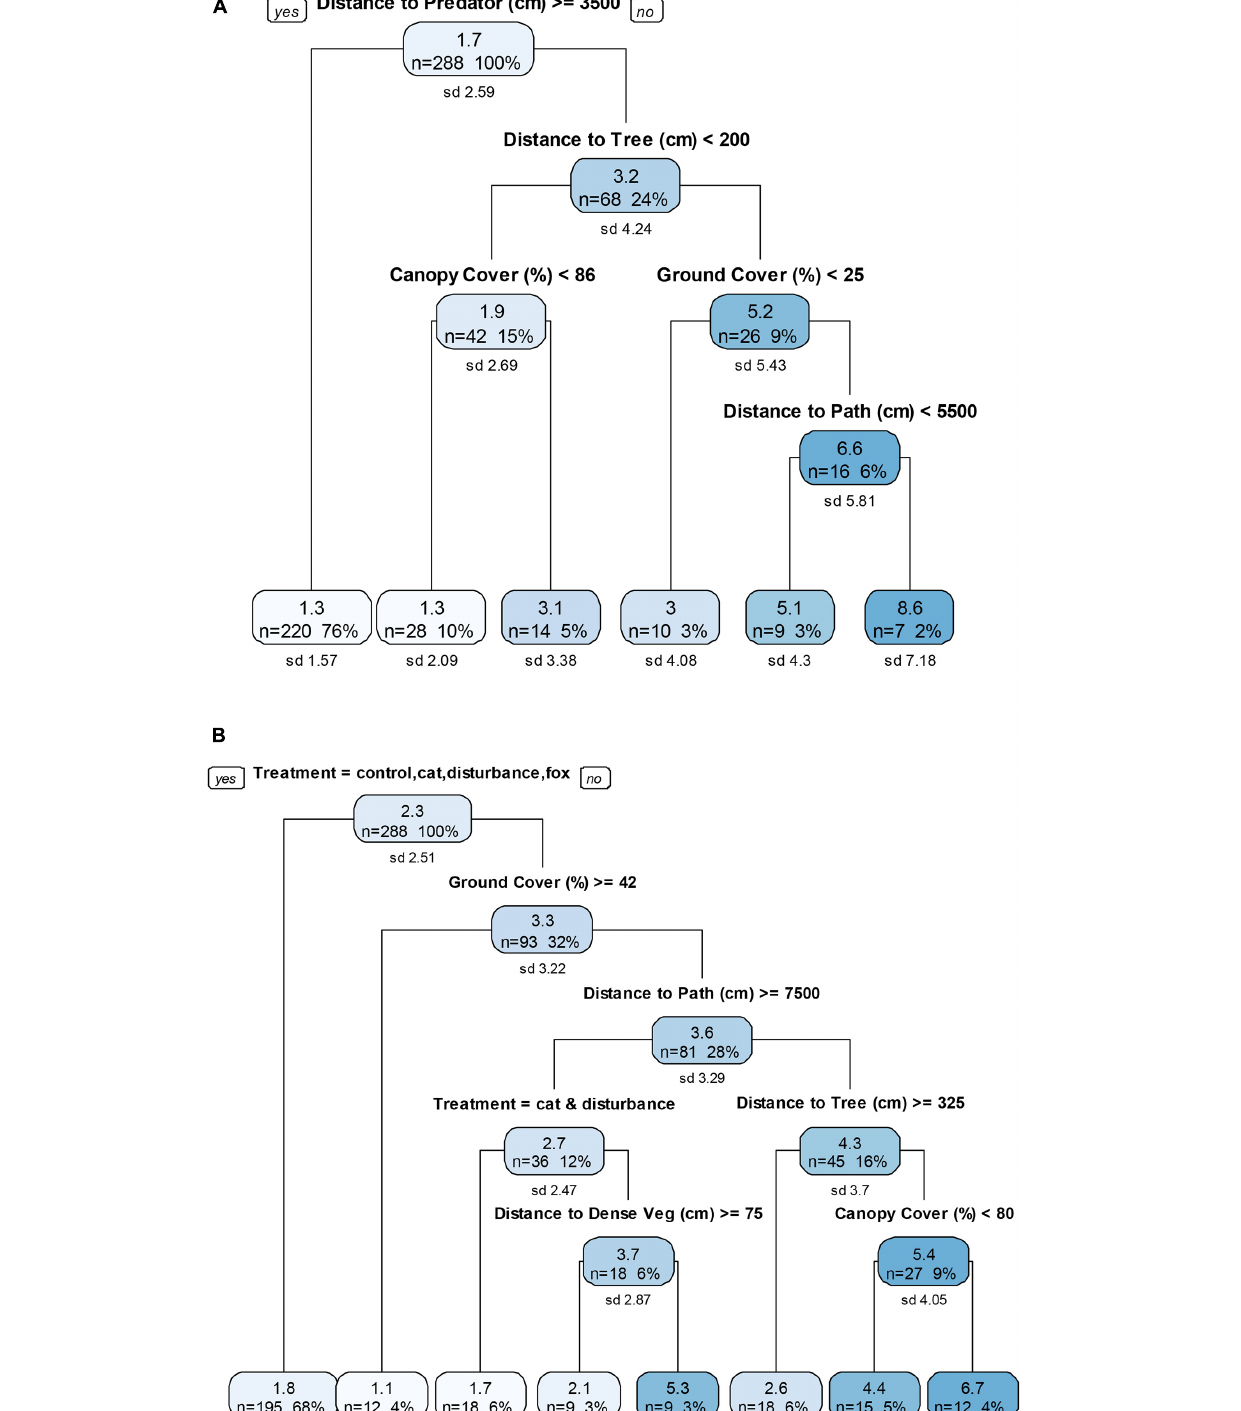
Frontiers in Ecology and Evolution |